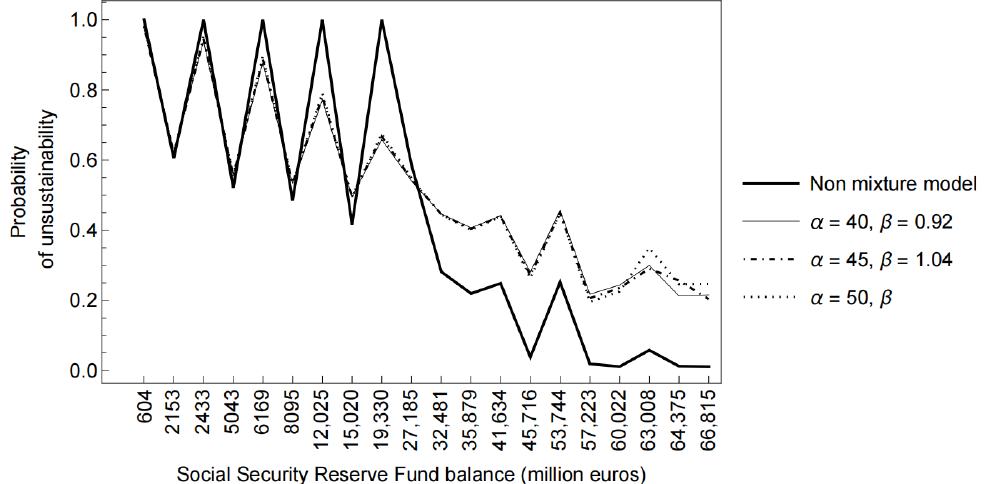
Figure 4. Probabilities of unsustainability for the Non-mixture model and for the mixture model. Source: Devised by the authors.